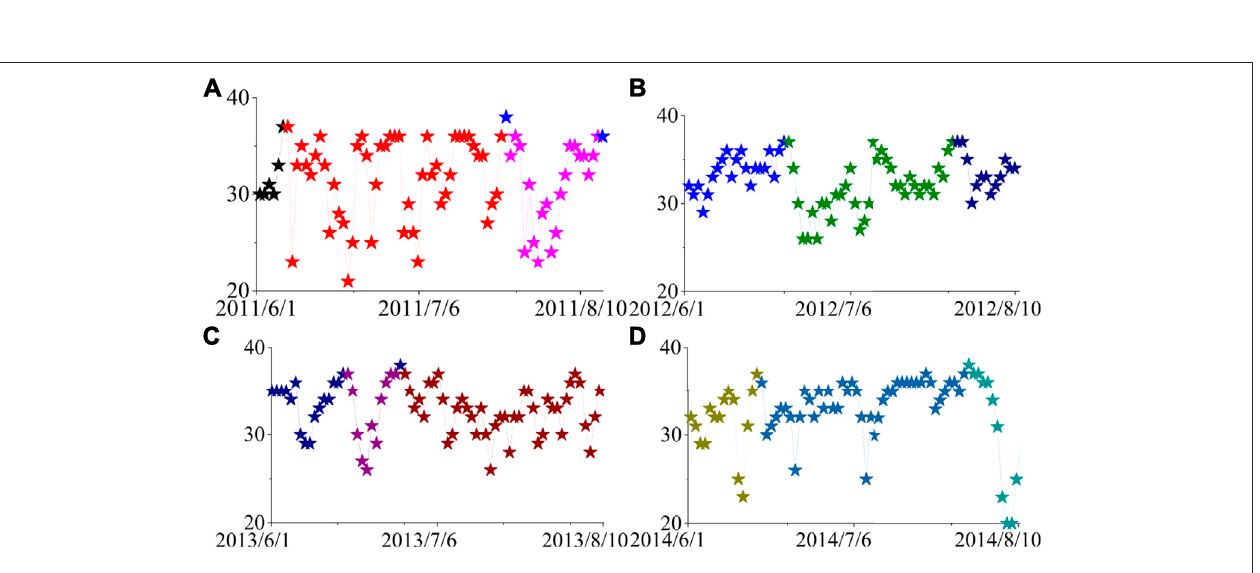
FIGURE 7 | Local magni fi cation of Figure 6